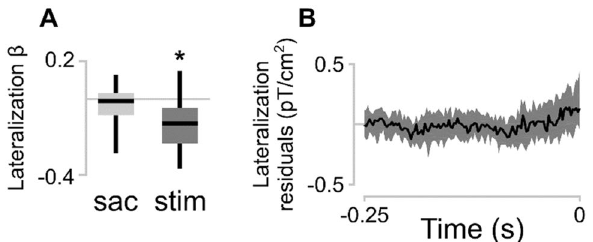
Figure 4. ( A ) Lateralization of the beta coefficients. The median beta coefficient of right lateralized sensors was subtracted from the median beta coefficient of the left lateralized sensors. Boxplots represent the median and dispersion across participants. Asterisk indicates that the mean significantly deviates from zero ( p < 0.001). ( B ) Lateralization of residual planar gradients: residuals from sensors on the left side of the helmet minus the residuals from sensors on the right side. Line represents the median; shaded area represents the interquartile range across